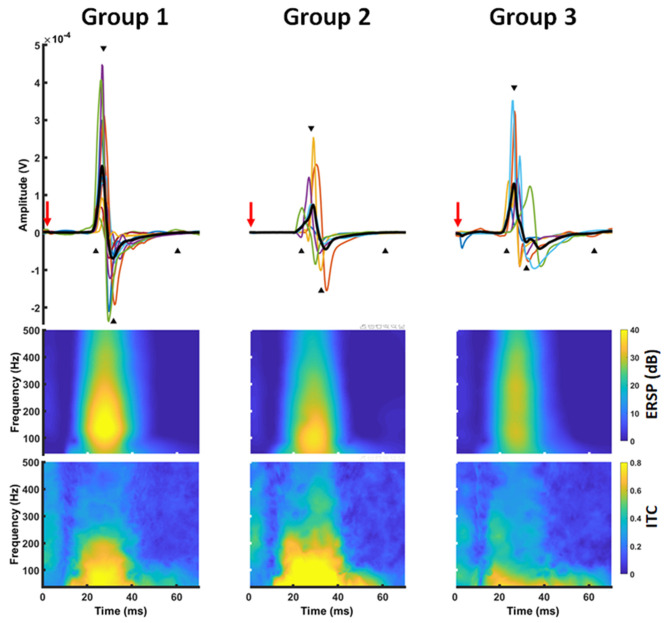
Time-frequency representation of a MEP. MEP time series (upper row) were transferred into the frequency domain using a Morlet wavelet approach. The transformation revealed a power increase (ERSP) ~20–50 ms after TMS application (red arrow) in a frequency band between 30 and 300 Hz with a local maximum around 100 Hz (middle row). At the same time, there was a high inter-trial-coherence covering the frequency and time range (lower row).